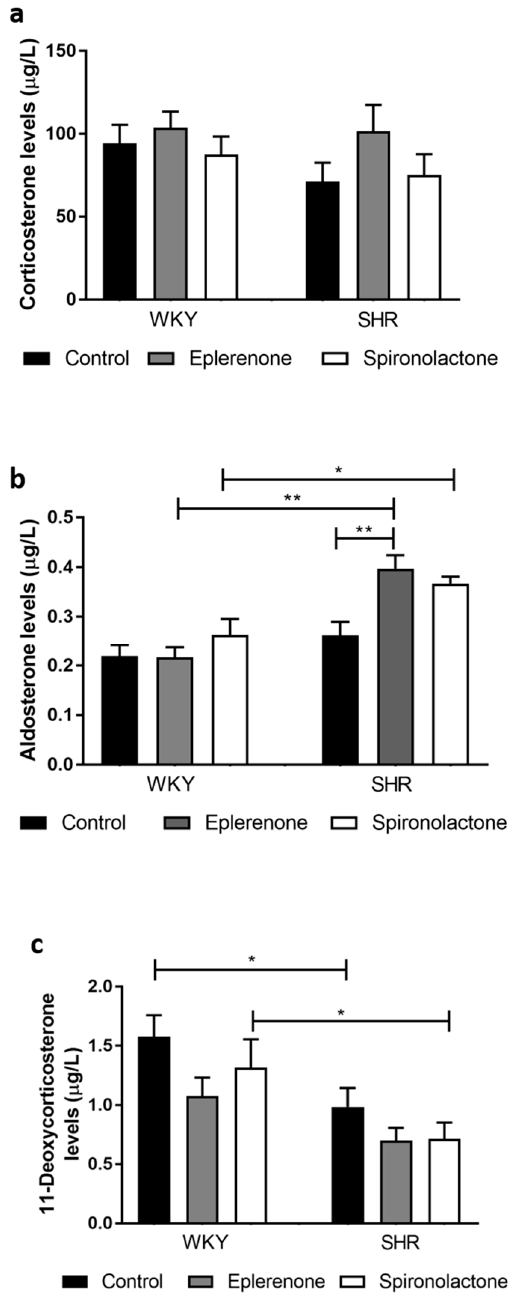
Figure 5. Corticosterone ( a ); aldosterone ( b ); and 11-deoxycorticosterone ( c ) plasma levels in Wistar Kyoto (WKY) and Spontaneous Hypertensive rats (SHR). * p < 0.05; ** p < 0.01. Aldosterone levels were significantly higher in MRA treated SHR as compared to WKY normotensive rats’ ( p < 0.05; Figure 5b). In addition, aldosterone levels were higher in eplerenone treated SHR as compared to non-treated SHR (SHR control: 0.26 ± 0.03 µ g/L vs. SHR eplerenone: 0.40 ± 0.03 µ g/L, p < 0.01) Lower 11-deoxycorticosterone levels were observed in untreated SHR compared with non-treated normotensive WKY rats (WKY control: 1.58 ± 0.18 µ g/L vs. SHR control: 0.99 ± 0.16 µ g/L, p < 0.05). Similarly, spironolactone treated SHR rats showed lower 11-deoxycorticosterone levels when compared to spironolactone treated normotensive rats (WKY spironolactone: 1.31 ± 0.24 µ g/L vs. SHR spironolactone: 0.72 ± 0.14 µ g/L; p <